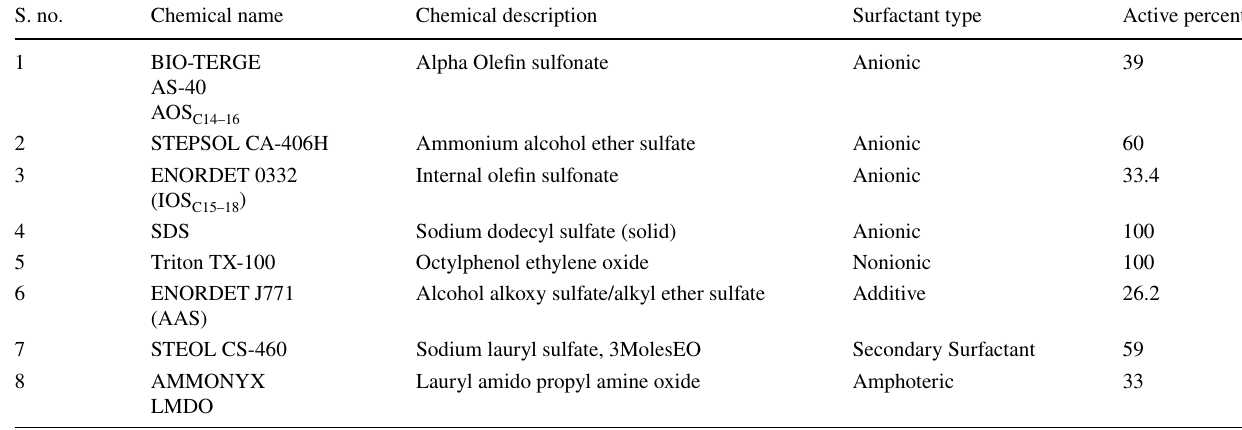
Table 1 List of surfactants used in the experiments S.